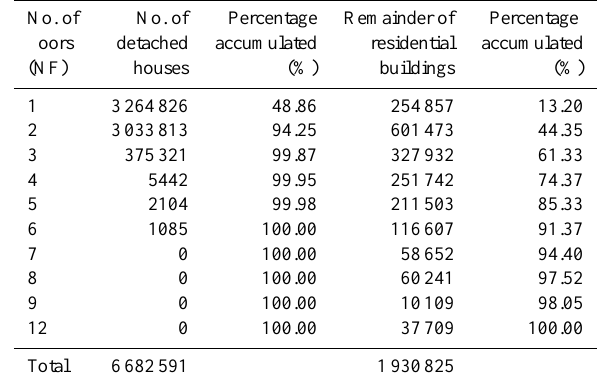
Table 4. Number of floors in residential buildings in Spain accord- ing to data from the INE